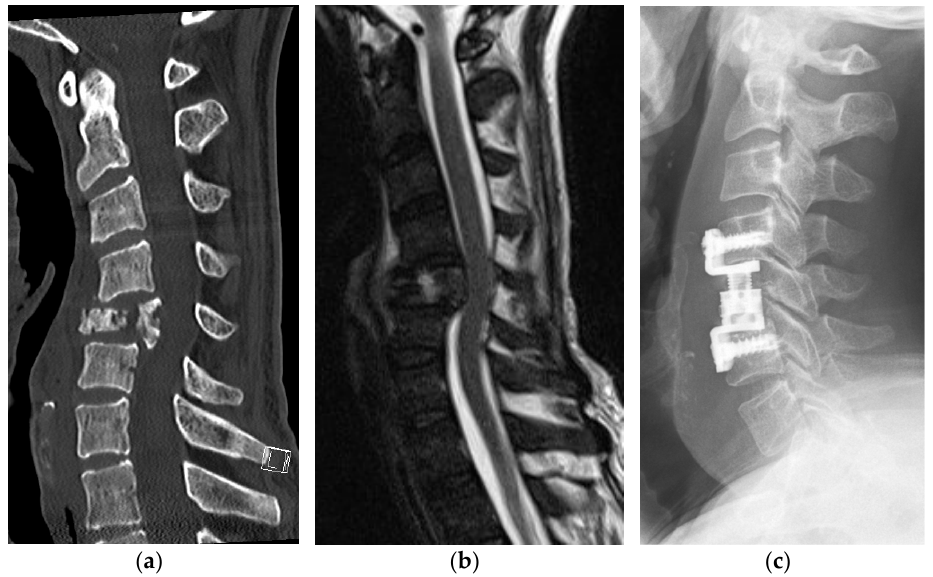
Figure 3. ( a – c ): Computed tomography in the sagittal plane ( a ) and sagittal view of T2-weighted magnetic resonance images ( b ) of a 48-year-old male patient with renal cell cancer. The pathologic fracture of the fifth cervical vertebra caused spinal instability and posterior dislocation of the vertebral body with incomplete spinal cord compression (ESCC grade 2). The lateral radiograph ( c ) demonstrates the postoperative result following corpectomy and cage implantation.